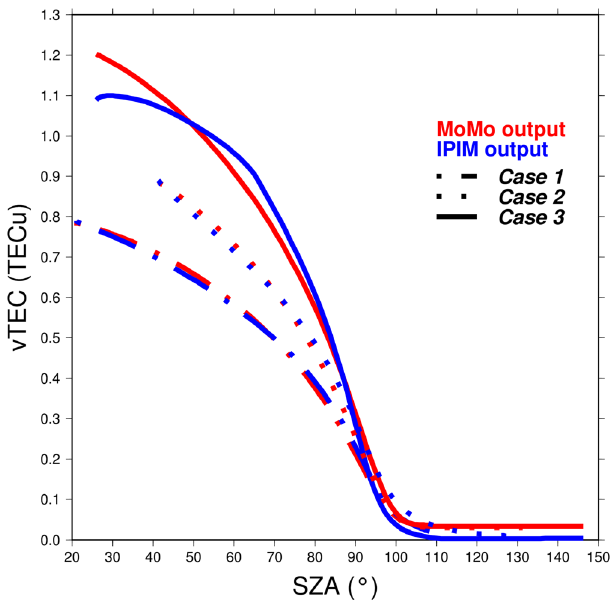
Fig. 6. Comparison between MoMo empirical model and IPIM numerical model. The three cases correspond to different locations, solar activity levels and seasons (see description in the text). In red are the MoMo outputs while in blue are the IPIM